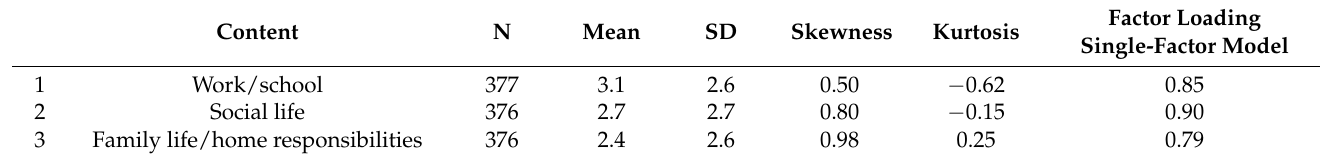
Table 1. Mean, SD, skewness, and kurtosis of SDS items ( N = 377).